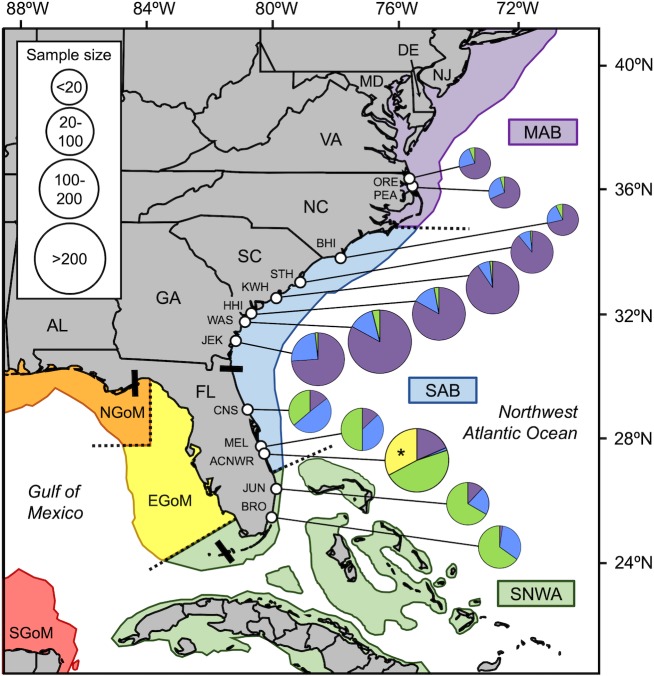
Summary of foraging-area origins based on stable isotopes from female loggerheads nesting in the NWA.Black bars separate beaches used by different recovery units: Northern, Peninsular Florida, Dry Tortugas, Northern Gulf. Nesting/sampling sites: ORE, north of Oregon Inlet, North Carolina (NC); PEA, Pea Island, NC; BHI, Bald Head Island, NC; STH, South Island, South Carolina (SC); KWH; Kiawah Island, SC; HHI, Hilton Head Island, SC; WAS, Wassaw Island, Georgia (GA); JEK, Jekyll Island, GA; CNS, Canaveral National Seashore, Florida (FL); MEL, Melbourne Beach, FL; ACNWR, Archie Carr National Wildlife Refuge, FL (Asterisk indicates stable isotope data that were not included in Fig 2 due to differing statistical approaches); JUN, Juno Beach, FL; BRO, Broward County beaches, FL. Foraging areas (colored areas separated by dashed lines): MAB, Mid-Atlantic Bight; SAB, South Atlantic Bight; SNWA, Subtropical Northwest Atlantic; EGoM, Eastern Gulf of Mexico; NGoM, Northern Gulf of Mexico; SGoM, Southern Gulf of Mexico. Data are from Ceriani et al. [16,22], Pajuelo et al. [14], Price et al. [29], Vander Zanden et al. [15], and this study (S3 Table). Base map generated using the SEATURTLE.ORG Maptool [17].